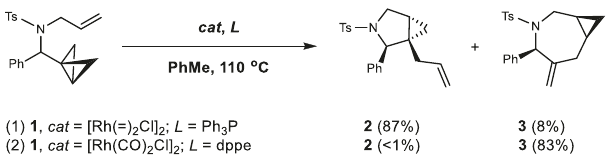
Fig. 1 | Ligand-controlled reaction outcome. Regio- and diastereoselectivity of Rh(I)-catalyzed cycloisomerizationsof bicyclo[1.1.0]butanes.Underthecatalysisof Rh(I)/PPh 3 , the reaction mainly generates fi ve-membered product ( 2 ). In contrast, employing Rh(I)/dppe as catalyst favors seven-membered product ( 3 ) formation.